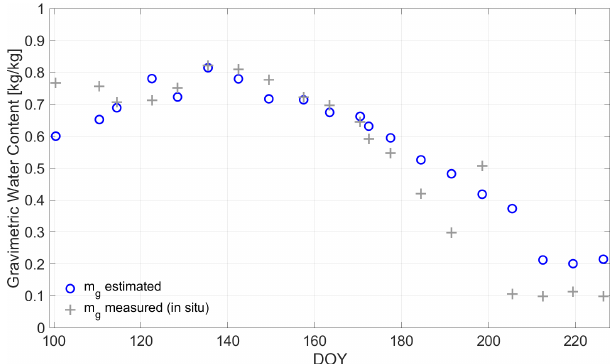
Figure 10. Measured (gray crosses) and radiometer-derived (blue circles) gravimetric vegetation water content ( m g ) [kgkg − 1 ] of winter wheat along days of year (DOY) in the growing season of 2017 at the field laboratory in Selhausen, Germany (Meyer et al.,